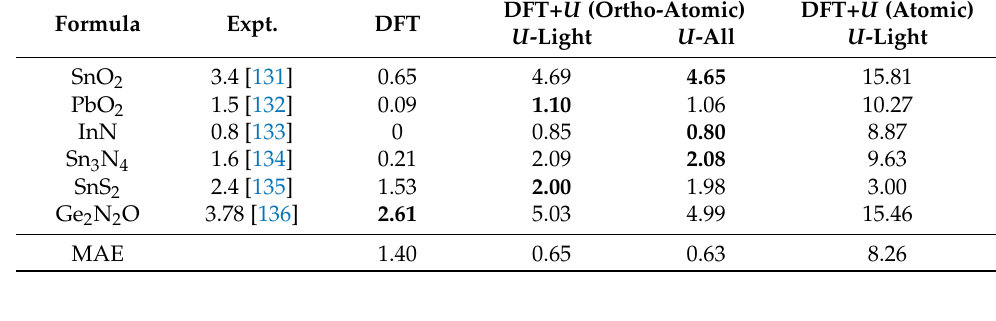
Table 4. Comparison of the band gaps (in eV) as computed using DFT and DFT+ U (using ortho-atomic and atomic projectors) and as measured in experiments for compounds containing group III-IV elements (Ge, In, Sn, Pb), with the mean absolute error (MAE) given for each method. DFT+ U calculations using ortho-atomic projectors are split into two columns: (1) band gaps predicted with U corrections applied only to the p states of light elements O, N, and S ( U -Light), and (2) band gaps predicted with U corrections applied to the p states of group III-IV and light elements ( U -All). For atomic calculations, band gaps were predicted with U corrections applied only to the p states of light elements ( U -Light). The computationally predicted band gaps with the closest values to the experimental band gaps are highlighted in bold. Formula Expt.